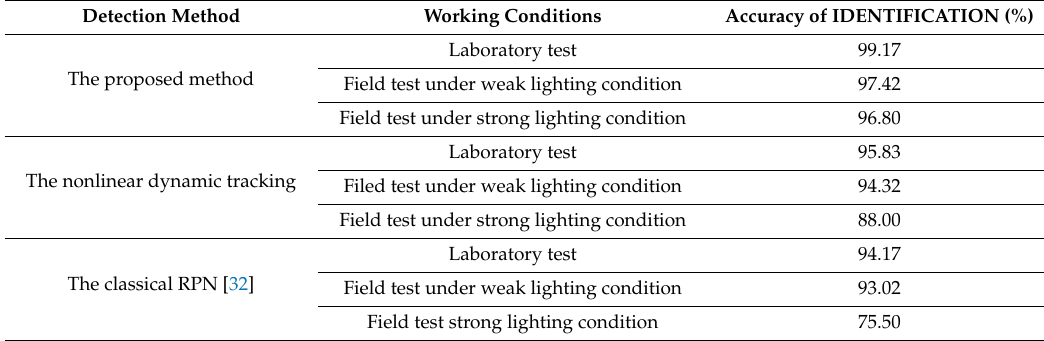
Table 2. Performance of di ff erent methods of contact wire vibration measurement under di ff erent test conditions.